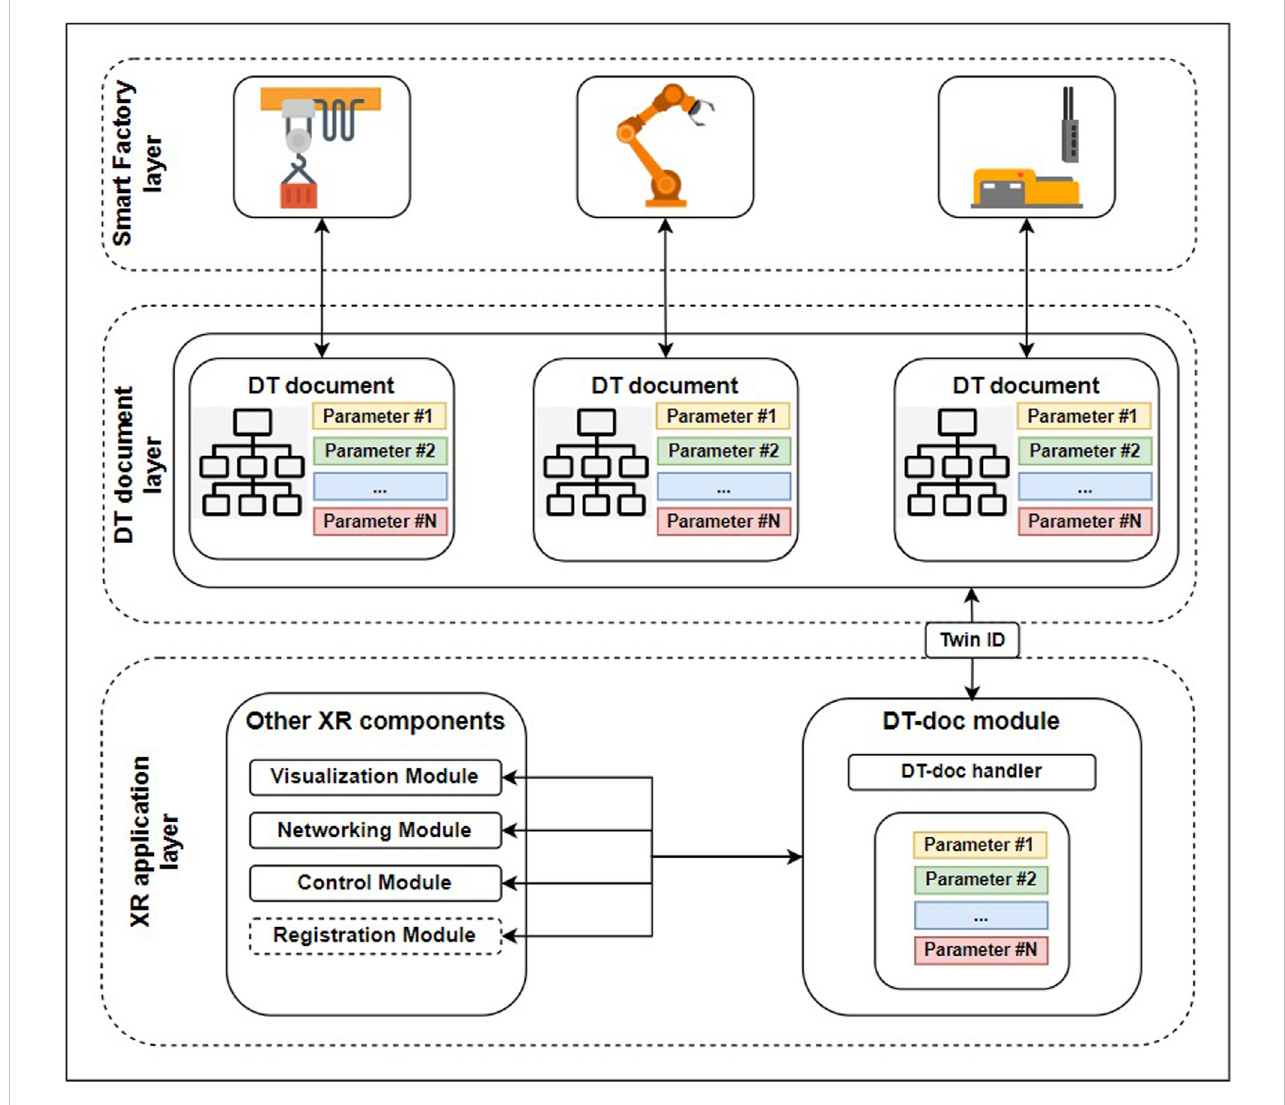
FIGURE 1 Overall architecture of the TwinXR method setup, with three layers from Smart Factory, DT document, to XR application.